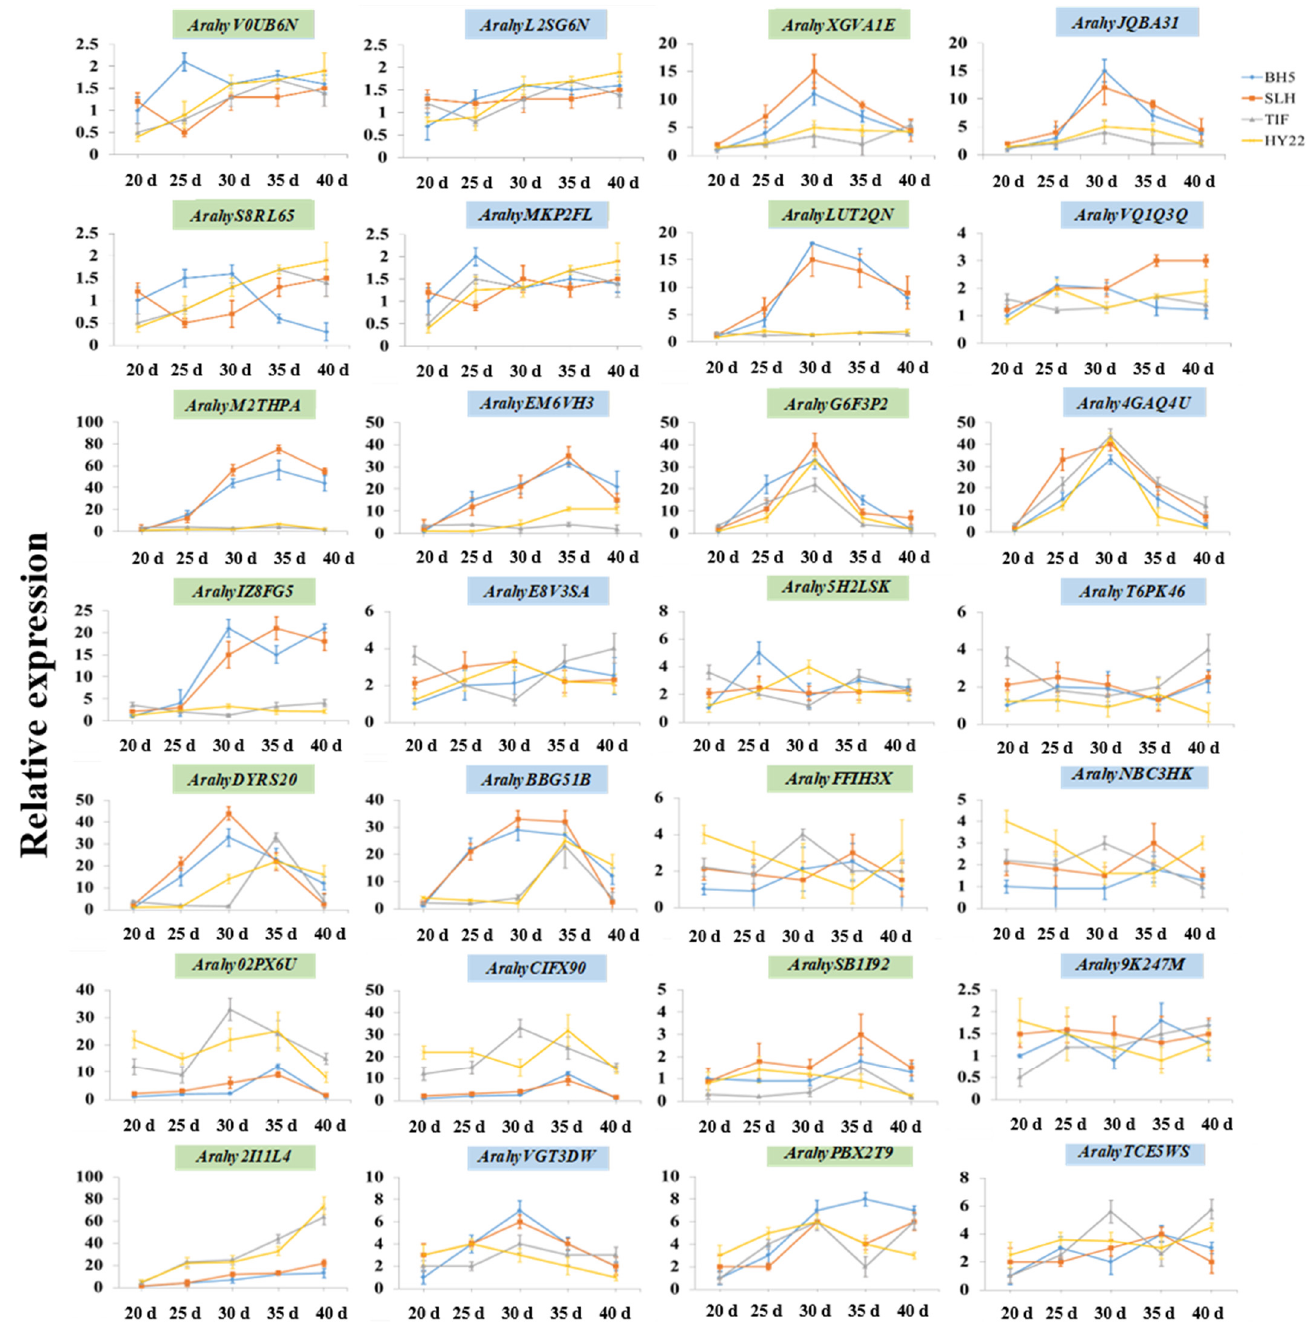
Figure 8. The relative expression patterns of early and late ‐ flowering peanut genotypes. Three biological replicates with their respective three technical replicates were performed.